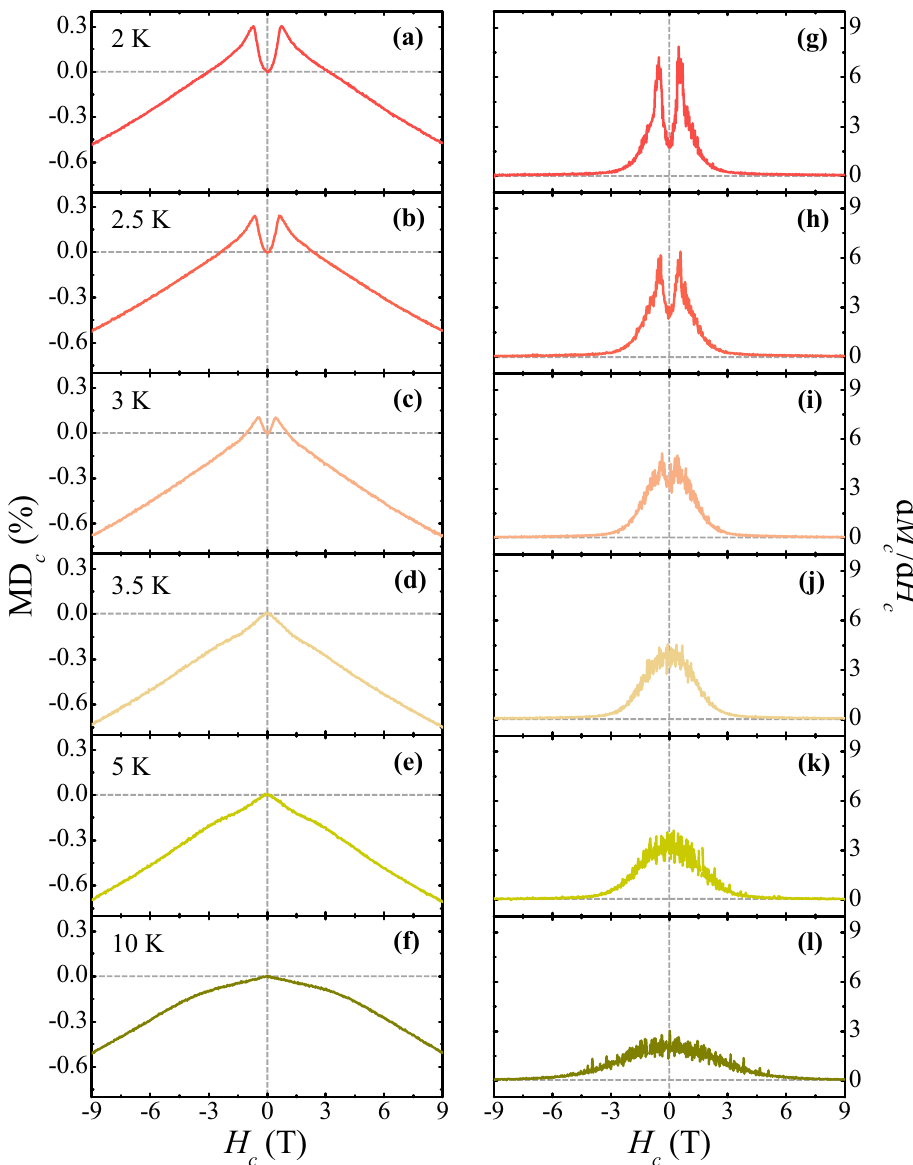
Figure 5. Temperature evolution of magnetodielectric effect along the c axis. ( a )–( f ) H c dependence of MD c at T = 2, 2.5, 3, 3.5, 5 and 10 K. ( g )–( l ) H c derivative of M c and d M c /d H c measured at T = 2, 2.5, 3, 3.5, 5 and 10